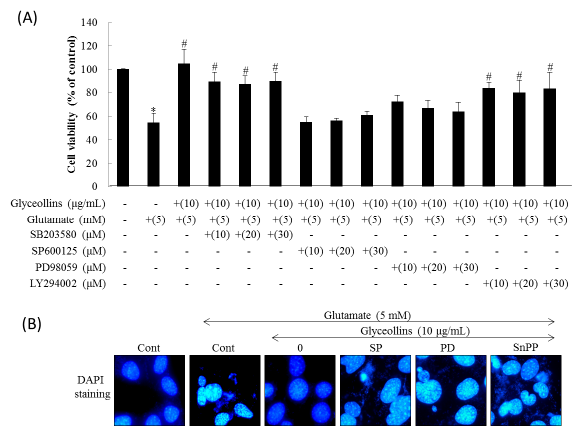
Figure 2. Effects of inhibitors for MAPK, PI3K, and HO-1 on the attenuation of glutamate-induced neurotoxicity by glyceollins. Mouse hippocampal HT22 cells were seeded at a density of 2 × 10 3 cells/well into 96-well plate and 3 × 10 4 cells/well into the gelatin-coated 24-well plate for assessment of morphology or DAPI staining, respectively. ( A ) HT22 cells were treated with MAPK or PI3K inhibitors in the presence of glyceollins (10 μ g/mL) and glutamate (5 mM) for 24 h, followed assessing cell viability by MTT assay. Bars represent mean ± SD ( n = 4). Marks above each bar indicated the significant difference. *, Significantly different from the untreated control ( p < 0.05). #, Significantly different from the positive control group treated with glutamate alone ( p < 0.05); ( B ) HT22 cells were treated with ERK inhibitor (SP), JNK inhibitor (PD), or HO-1 inhibitor (SnPP) in the presence of glyceollins (10 μ g/mL) and glutamate (5 mM) for 24 h, followed by DAPI staining and visualizing under fluorescent microscope to evaluate cytotoxicity (magnification, 400×).